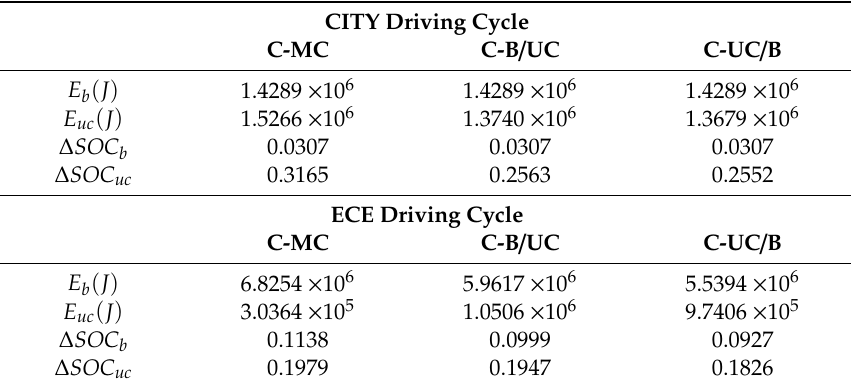
Table 4. Comparison of di ff erent configurations before di ff erent driving